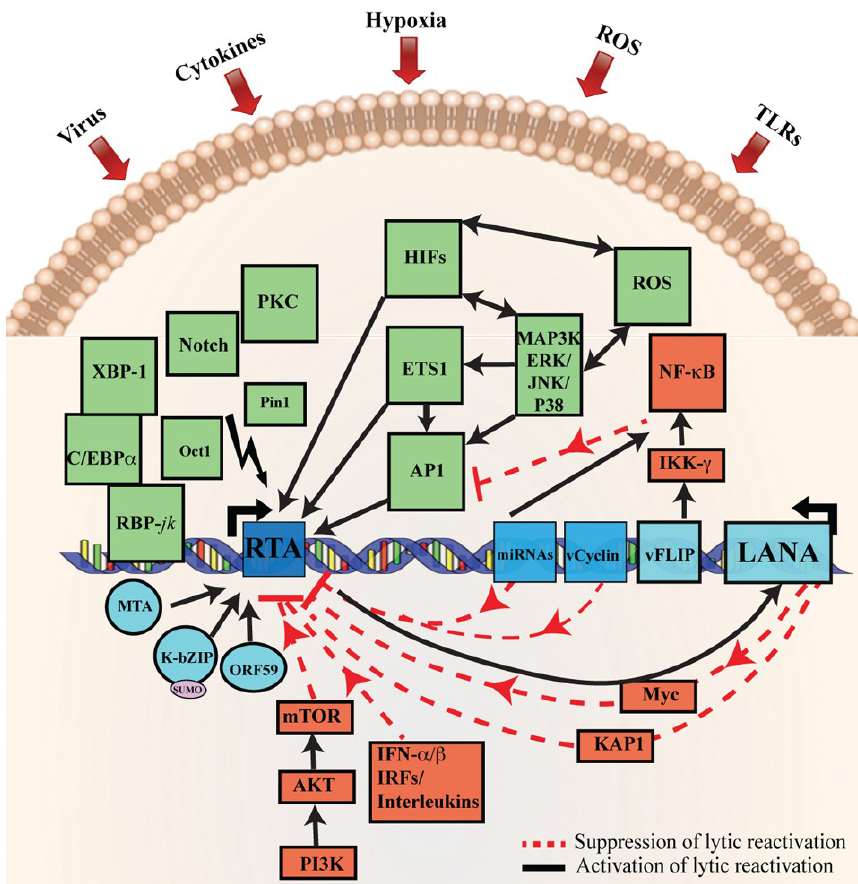
Figure 2. Schematic representation of cellular signaling pathways involved in KSHV latency and reactivation. During latency, KSHV latent genes, including LANA, vFLIP, miRNA, and vCyclin activate and maintain various cytokine-mediated cell proliferation and angiogenesis pathways, such as JAK/STAT, PI3K/AKT/mTOR, cMyc, and NF-κB, to suppress KSHV lytic reactivation. The red line represents the inhibitory pathways involved in the maintenance of KSHV latency. Disruption of these signaling pathways by various stimuli, such as secondary infection by bacteria, viruses, hypoxia, inflammatory cytokines, and oxidative stress upregulate RTA expression resulting in KSHV reactivation. The solid black arrows represent signaling pathways that are activated during KSHV lytic